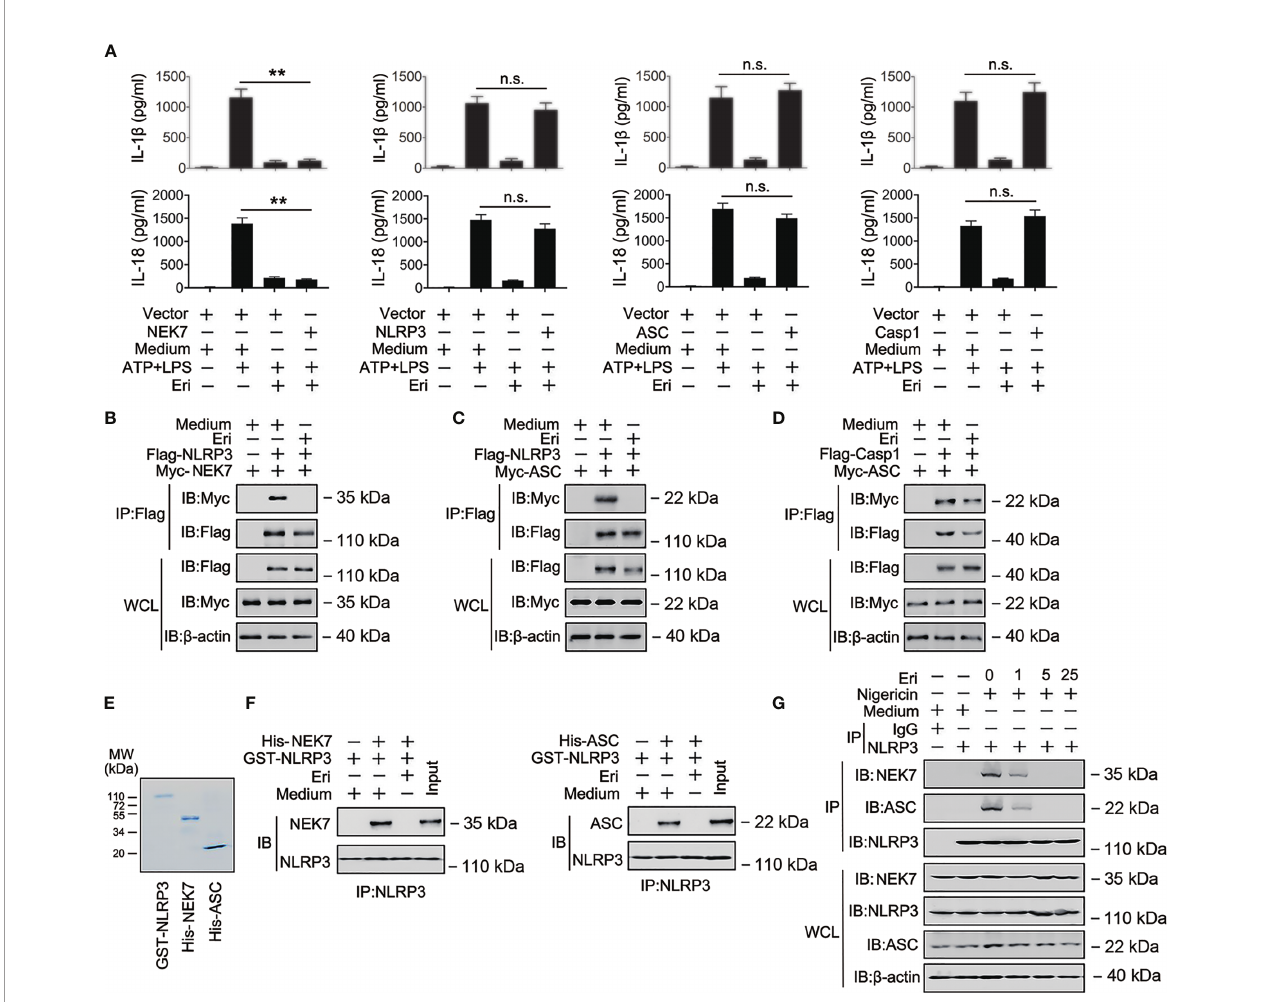
FIGURE 3 | The role of Eri in NLRP3 in fl ammasome assembly. (A) THP-1 cells were co-transfected with the indicated plasmid for 36 h, then treated LPS (1 µg/ml) for 6 h and ATP (2.5 mM for 30 min). IL-1 b and IL-18 protein levels were determined by ELISA. (B) HEK293T cells were transfected with Flag-tagged NLRP3 (Flag- NLRP3) or Myc-tagged MEK7 (Myc-MEK7) for 36 h. Then, cells were treated with Eri (5 nM) for 6 h. Co-IP and immunoblot analysis were performed with the indicated antibodies. (C, D) Experiments were performed as described in (B) , except Myc-ASC (C) or Myc-ASC and Flag-Casp-1 (D) were used. (E, F) Puri fi ed GST-NLRP3, His-MEK7, and His-ASC were mixed (3 nM) in various combinations as indicated, and incubated with Eri (3 nM). The solution was immunoprecipitated with indicated antibody and analyzed using western blotting. (G) THP-1 cells were treated with Nigericin (2 m M for 2 h) and Eri (5 nM for 6 h). Co-IP and immunoblot analysis were performed with the indicated antibodies. All experiments were repeated at least three times. Bar graphs present means ± SD (**P < 0.01; n.s., not signi fi